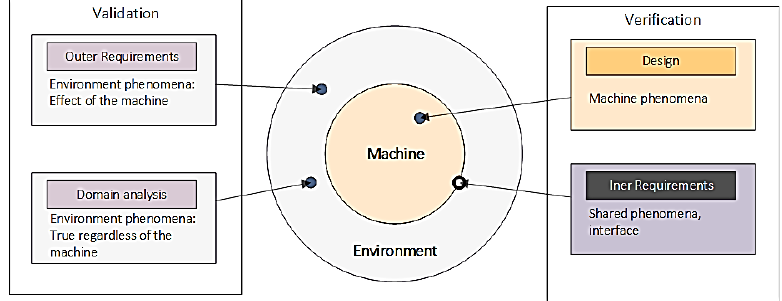
Figure 1: Jackson’s model: Environment, Machine and Boundary Figure 3. Jackson’s model: environment, machine and boundary